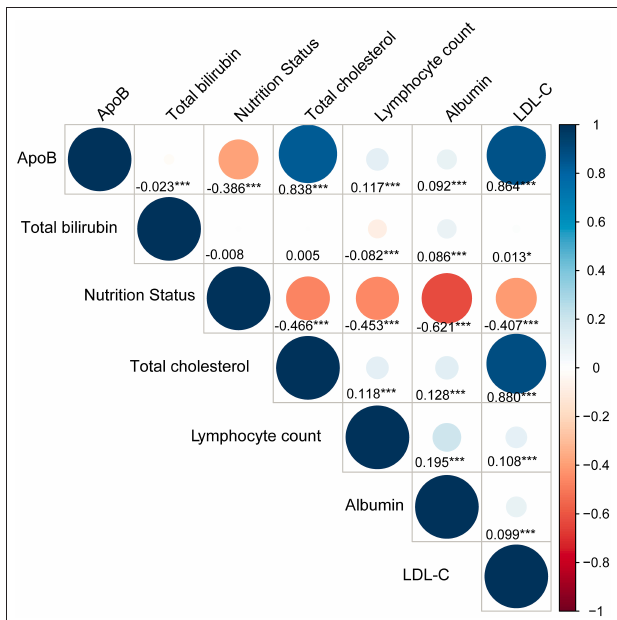
FIGURE 3 | Correlations between ApoB, total bilirubin, nutritional status and its components. Nutritional status is assessed by Controlling Nutritional Status (CONUT) score. Total cholesterol, lymphocyte count and albumin are components of CONUT score. p < 0.05 *; p < 0.01**; p <